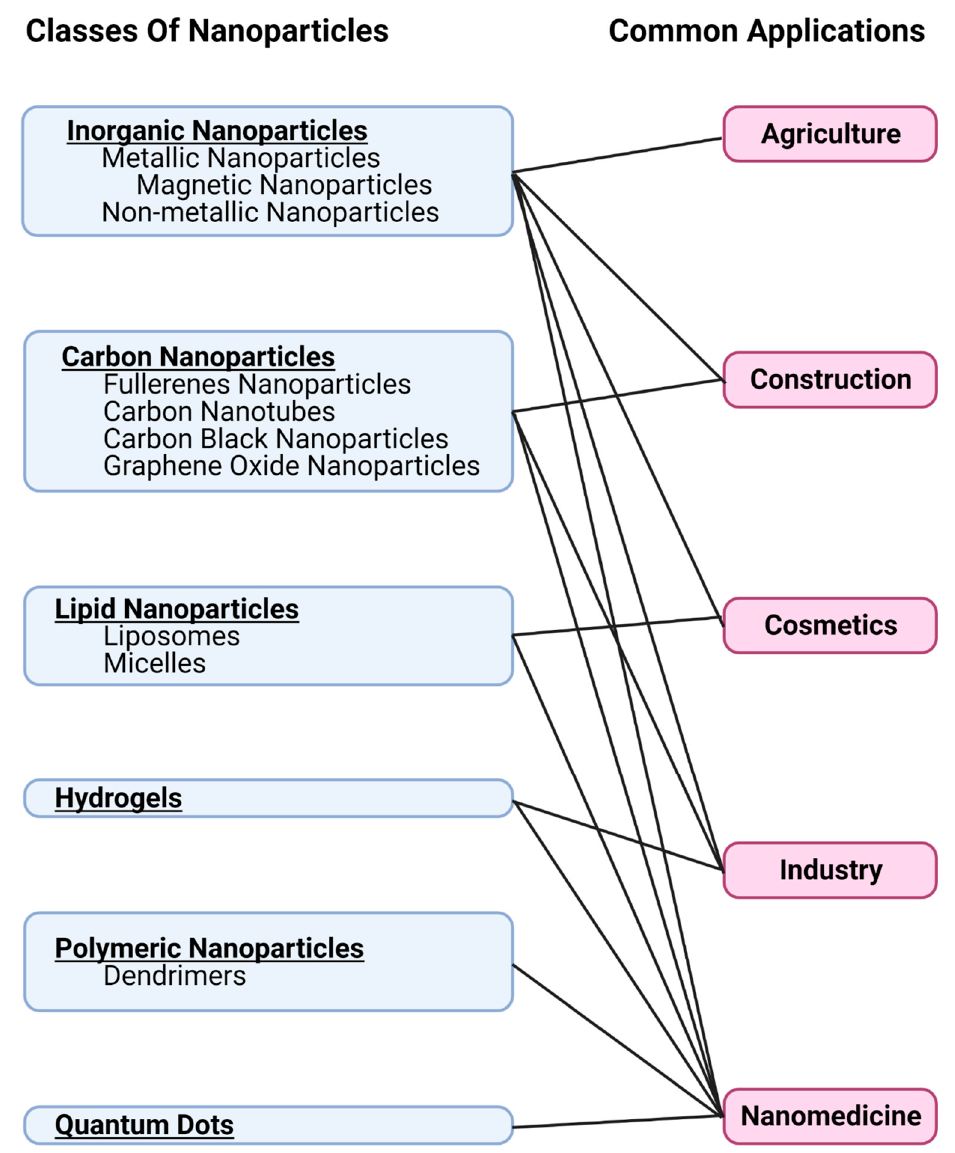
Figure 2. Nanoparticle classes and their applications.